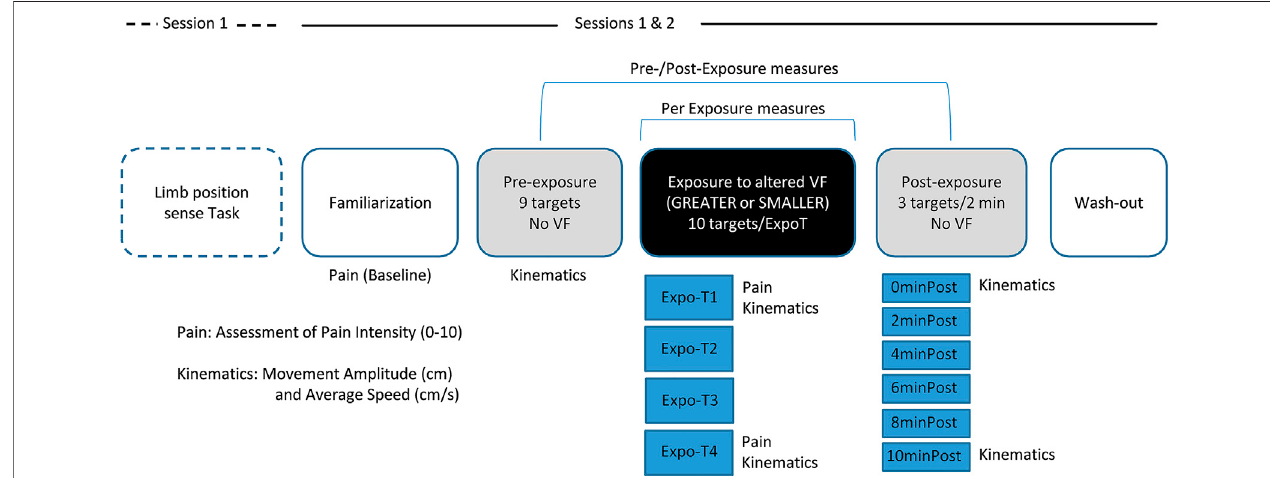
FIGURE1| StudyDesign.FirstsessionbeganwiththeLimbpositionsenseTask.Sessions1and2comprised:theFamiliarizationtask,thePre-exposuretaskwith no visual feedback (VF)comprising nine targets, the Exposure toaltered VF(GREATERor SMALLER) taskcomprising four blocks oftentargets, thePost-exposure task with no VF comprising six blocks of three of the nine initial targets, pseudo-randomly displayed every 2 min over a period of 10 min, and a Wash-out task. Pain Intensity wasassessedverballywithanumericalpainratingscale(NPRS)rangingfrom0to10duringtheFamiliarizationtask(Baseline),aswellasafterthe fi rst(Expo-T1)and last block (Expo-T4) of Exposure to altered VF. Kinematics measures (Movement Amplitude and Average Speed) were acquired during the reaching task in the Pre- Exposure, Exposure (Expo-T1 and Expo-T4) and Post-Exposure blocks.